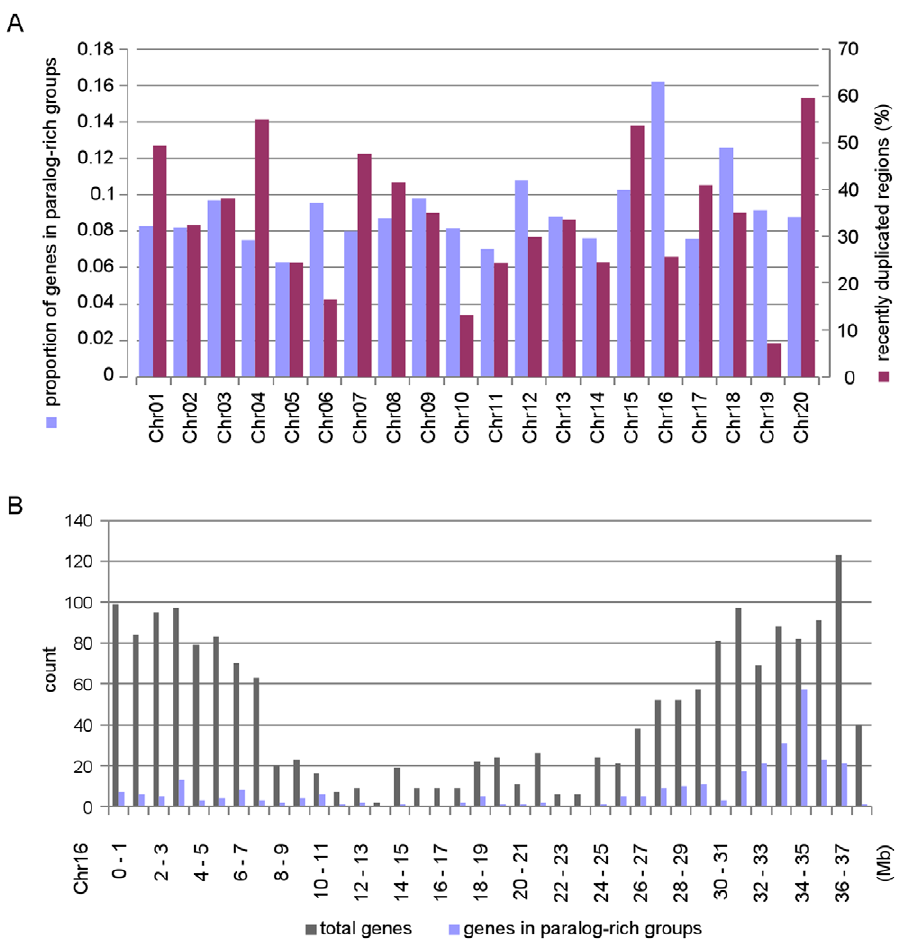
Figure 7. Distribution of genes in paralogue-rich groups in whole genome (A) and chromosome 16 (B). (A) Paralogue-rich orthologue groups and the percentage of recently duplicated segments per chromosome seems to have no apparent correlation. (B) In chromosome 16, a large number of the genes in paralogue-rich groups, mostly from OG5_134835 or OG5_170470, are condensed in the region around 34-35Mb (see the main text).